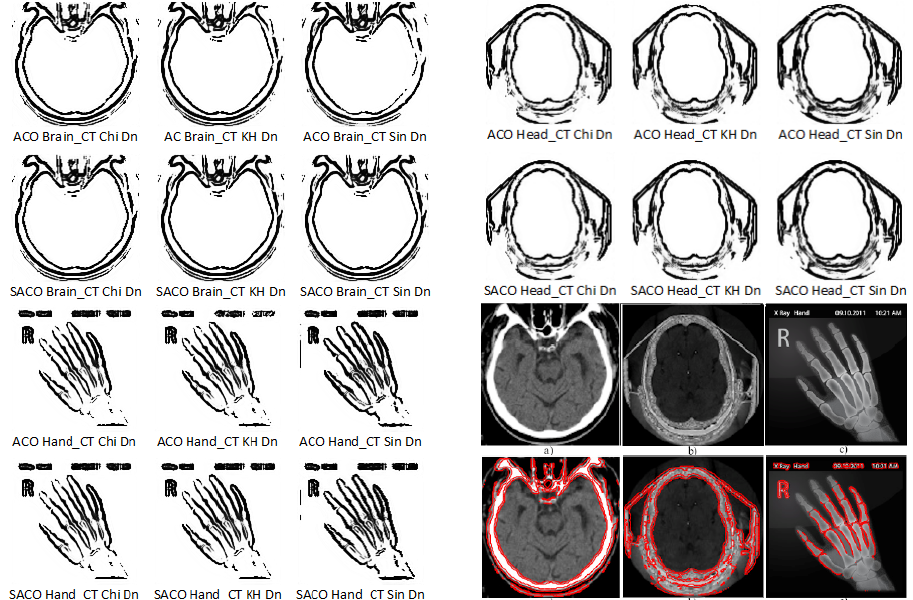
Figure 2. Successive illustrations of the best solutions obtained after 300,000 iterations with Ant colony optimization (ACO) and Sensitive ACO (SACO) post-processed with the Denoise Convolutional Neural Network (DnCNN) and the overlapped best solutions’ edges over the original medical images for ( a ) Brain CT; ( b ) Head CT and ( c ) Hand X-ray.